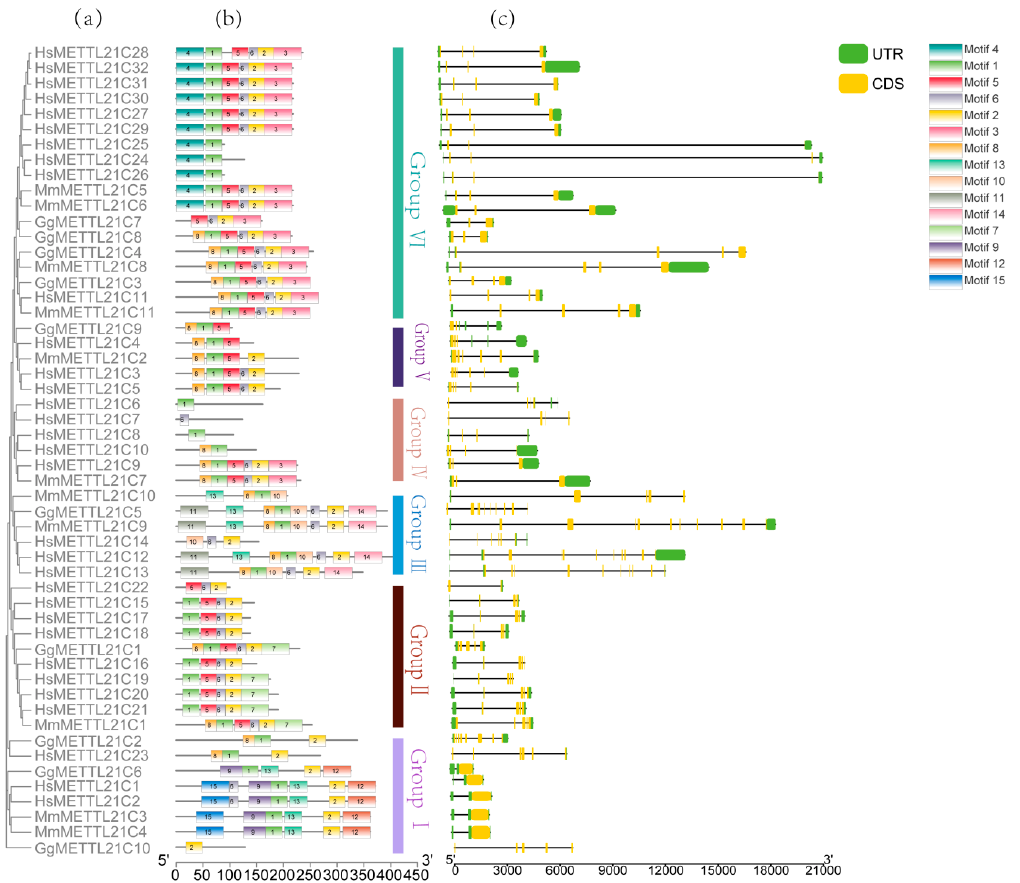
Figure 3. ( a ) Phylogenetic relationships, ( b ) motif compositions, and ( c ) gene structures of the 53 METTL21C genes identified in G. gallus (Gg), M. musculus (Mm), and H. sapiens (Hs). (a) Phylogenetic relationships using the NJ method, and different colors represent different groups. (b) Colored boxes indicate conserved motifs, and gray lines represent nonconserved sequences. The length of motifs in each protein is shown proportionally. (c) UTR represents upstream, CDS represents coding sequence, and EXON represents exon.